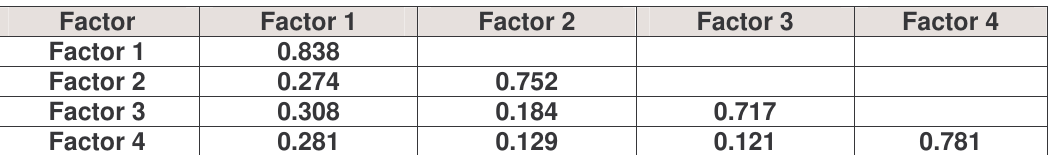
Table 1: Factor correlation for rotated